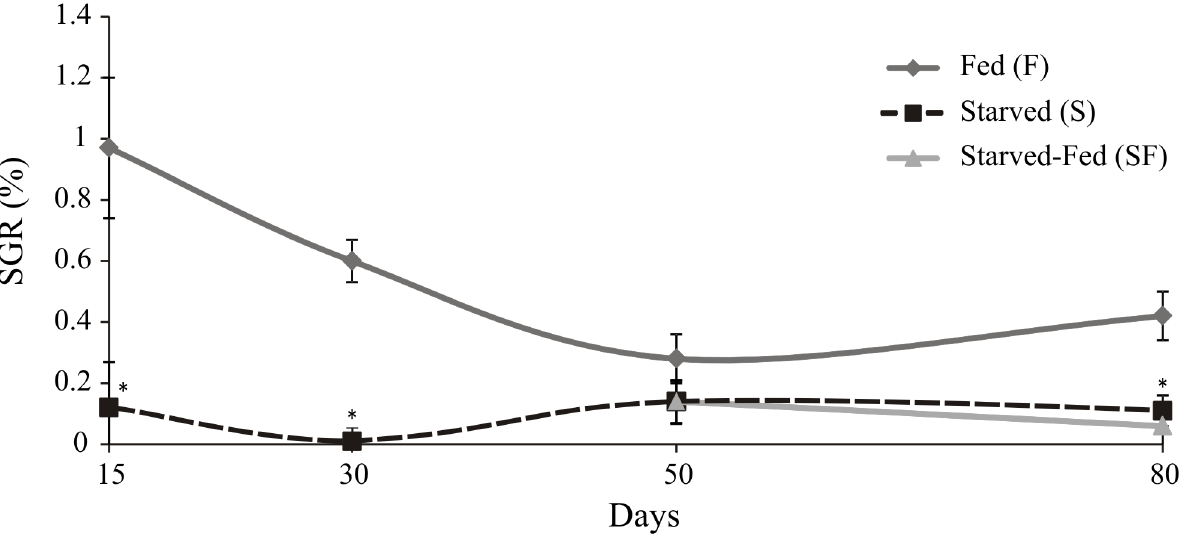
Fig 2. Cherax quadricarinatus juveniles ’ specific growth rate after starvation and posterior feeding. The statistical analysis was done among treatments (F, S and SF) at each experimental time (15, 30, 50, and 80 days). * indicates statistically significant differences (p <